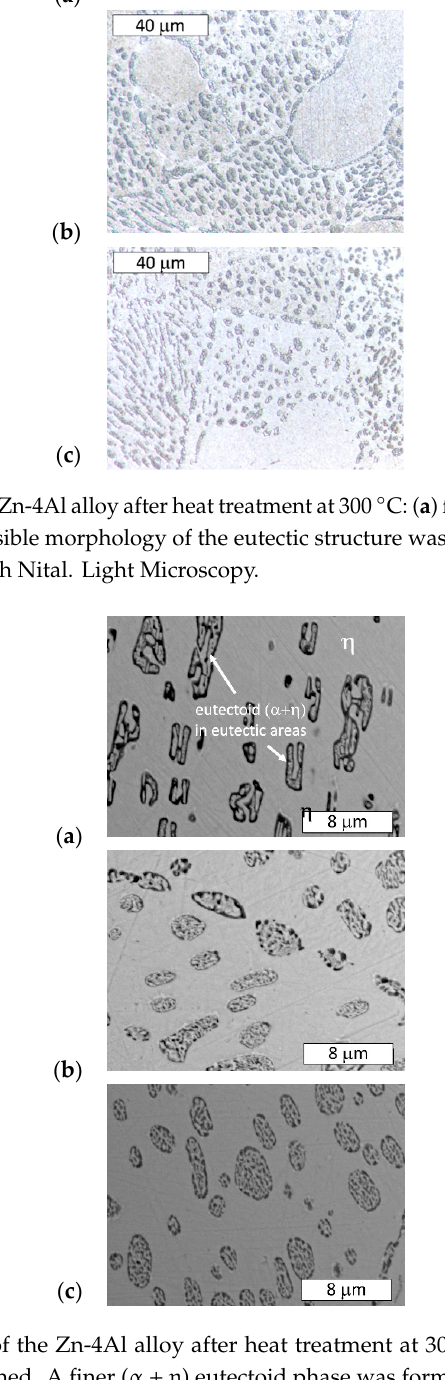
Figure 5. Microstructure of the Zn-4Al alloy after heat treatment at 300 °C: ( a ) furnace-cooled, ( b ) air-cooled, ( c ) water-quenched. A finer ( α + η ) eutectoid phase was formed from the γ phase. Etched with Nital. SEM.